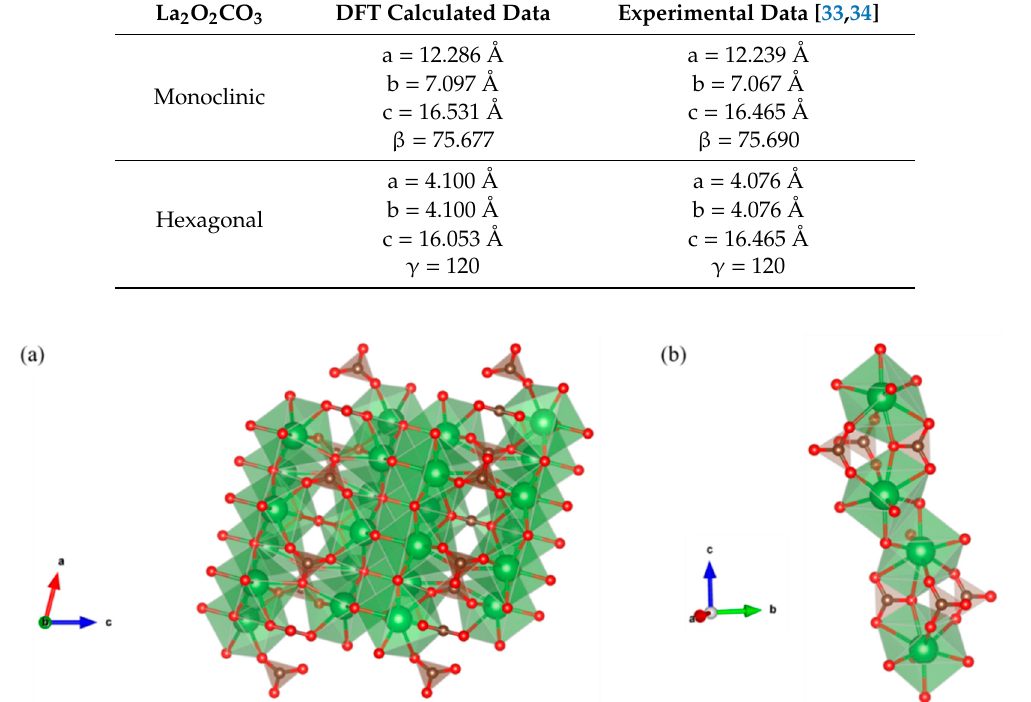
Figure 7. DFT-optimized structure of La 2 O 2 CO 3 in ( a ) monoclinic and ( b ) hexagonal phases.